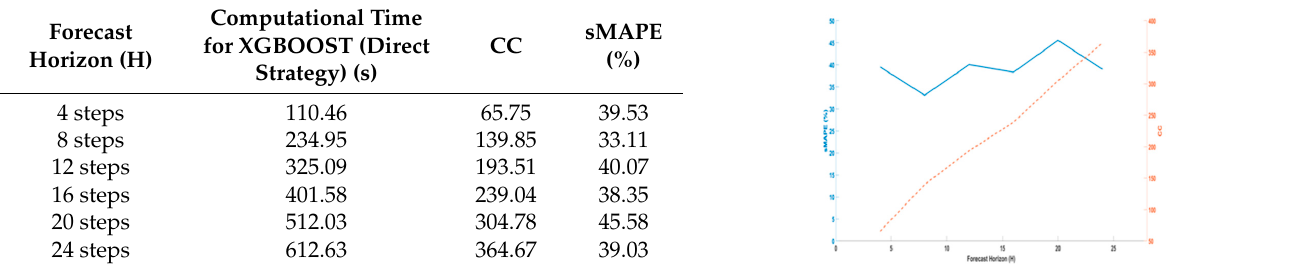
Table 8. Computational complexity and sMAPE for multistep ahead forecasting.